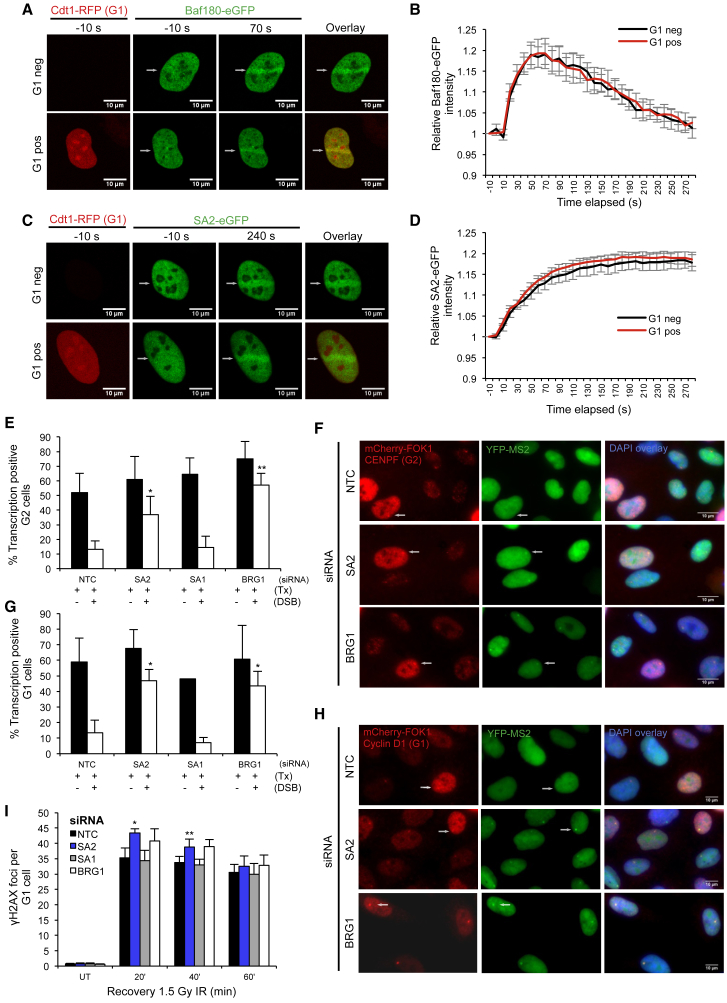
Cohesin- and PBAF-Dependent Transcriptional Repression at DNA Double-Strand Breaks Occurs in Both G1 and G2 Phases(A and C) Representative images of cells expressing GFP-BAF180 (A), GFP-SA2 (C), or Cdt1-RFP (to identify G1 phase cells) as indicated following laser microirradiation.(B and D) Quantification of GFP-BAF180 (B) or GFP-SA2 (D) recruitment to laser-microirradiation-induced damage in G1 cells (Cdt1-RFP positive) or cells outside of G1 (Cdt1-RFP negative). Data represent the relative mean signal intensity ± SEM for n = 6 (B) or n = 7 (D) biological repeats. At least 42 cells were analyzed in total for each construct per cell-cycle phase.(E) Quantification of transcription in CENPF-positive (G2 phase) U2OS reporter cells treated with the indicated siRNA (NTC, non-targeting control) with or without induction of the FokI endonuclease. Data are presented as the mean ± SD. More than 40 cells were analyzed per condition per repeat (n = 3 biological repeats).(F) Representative images of U2OS reporter cells analyzed in (E).(G) Quantification of transcription in cyclin-D1-positive (G1 phase) U2OS reporter cells treated with the indicated siRNAs. Data are presented as the mean ± SD. More than 40 cells were analyzed per condition per repeat (n = 3 biological repeats).(H) Representative images of U2OS reporter cells analyzed in (G).(I) Quantification of γH2AX foci clearance following exposure to 1.5 Gy IR in G1 phase (cyclin D1 positive) U2OS cells treated with the indicated siRNA. Data are presented as mean ± SD; n = 3 biological repeats.∗p < 0.05, ∗∗p < 0.01 using paired Student’s t test. See also Figure S2.